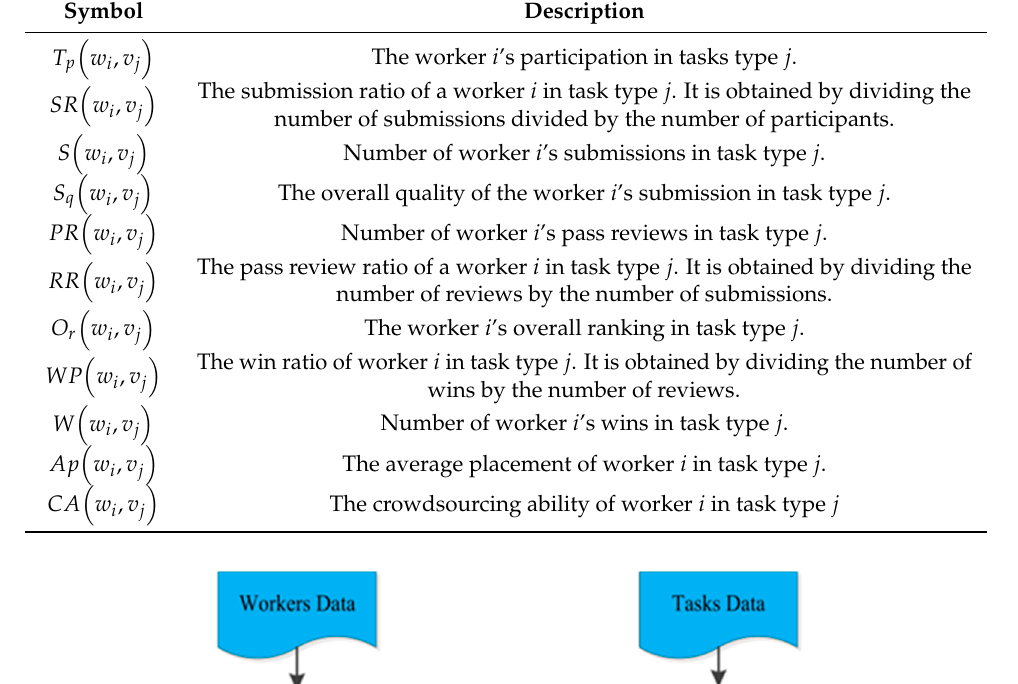
Table 1. Notations used in crowdsourcing ability model.